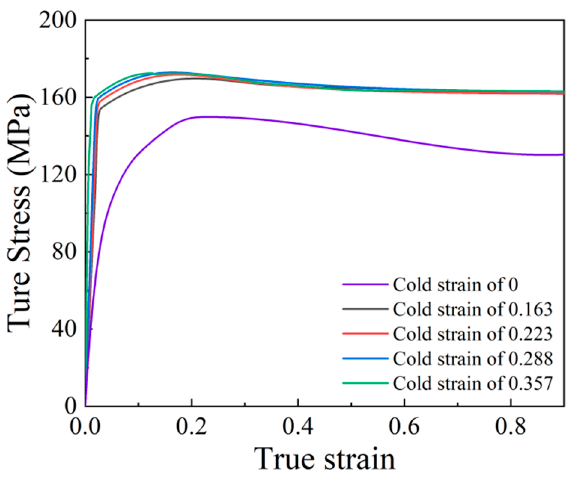
Figure 3. True stress–strain curves of the specimens with different cold strains subjected to thermal deformation at the temperature of 1323 K and a strain rate of 0.1 s − 1 .